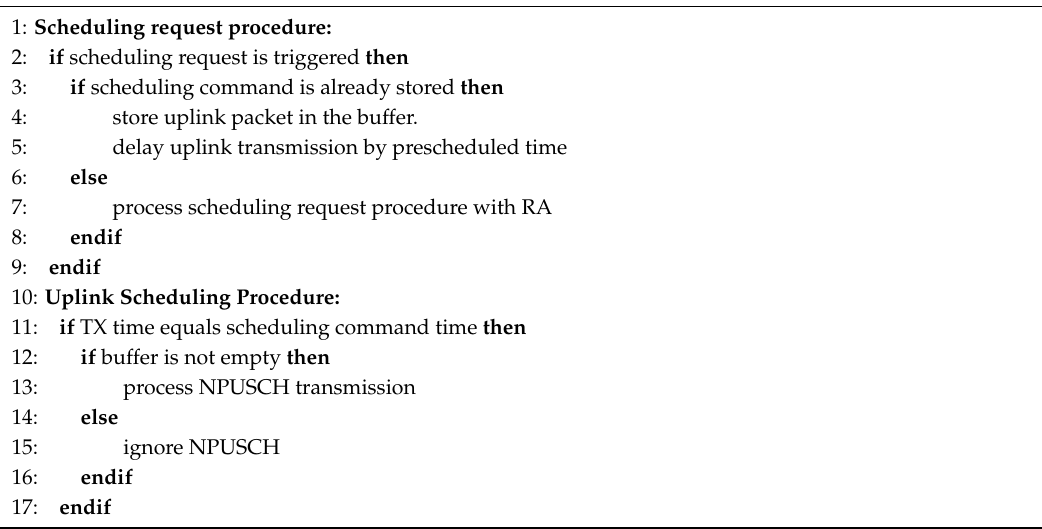
Algorithm 2. Proposed UE procedure in an NB-IoT